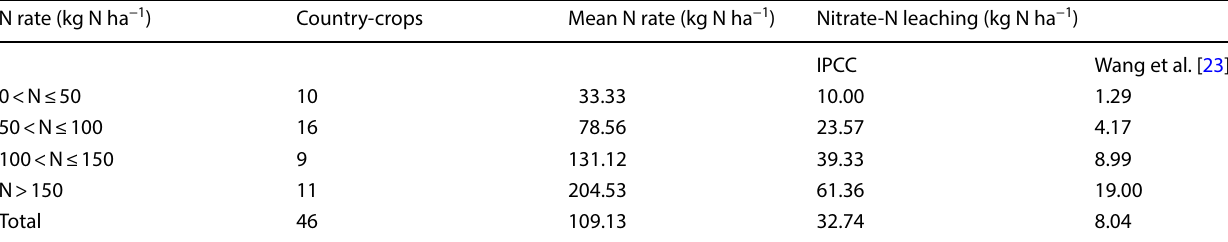
Table 1 Nitrate-N leaching as estimated by fixed 30% soil nitrate leaching emission factor as used by Intergovernmental Panel on Climate Change (IPCC) and by following the soil nitrate leaching